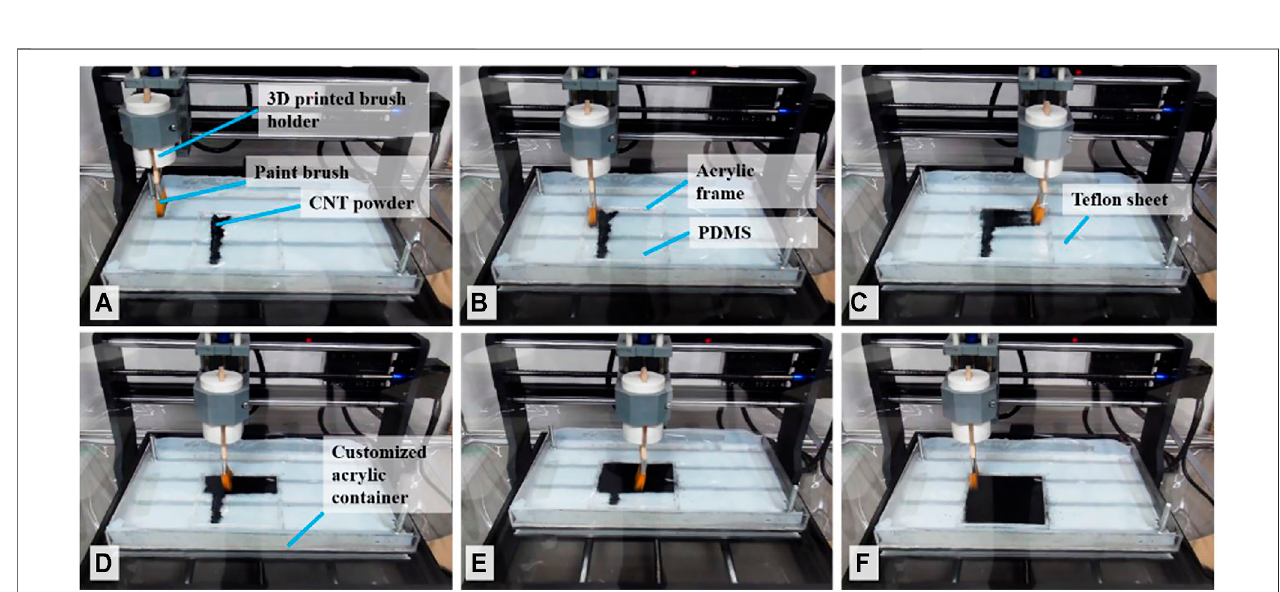
FIGURE 2 | Equipment setup and brushing process using a brushing machine. (See Supplementary Movie S1 to view the complete process).